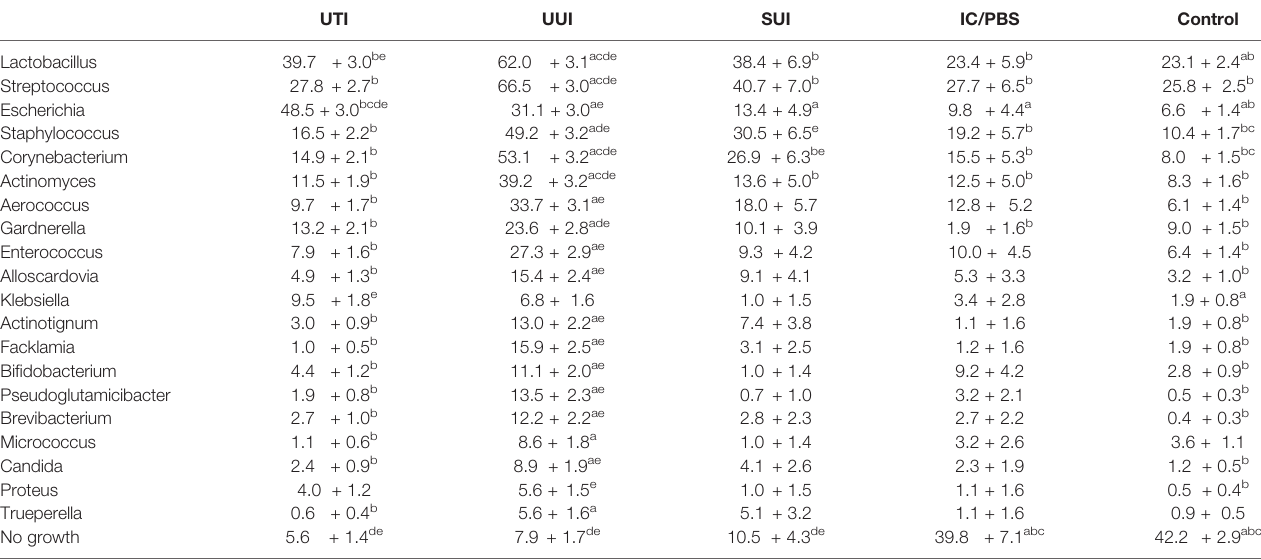
TABLE 3 | Age adjusted prevalence (%) ± standard